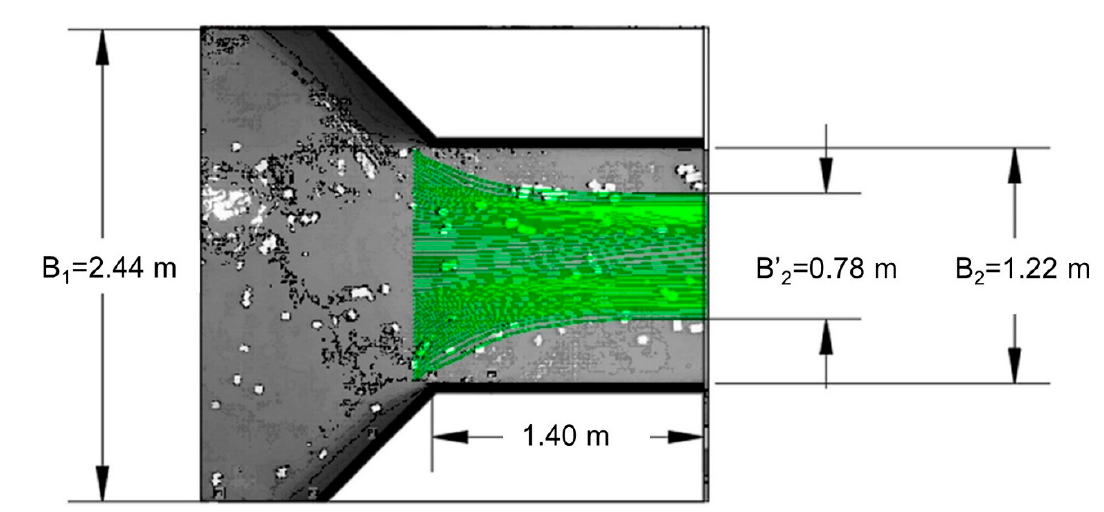
Figure 18. The measured value of vena contracta width B’ 2 obtained for experiment with B 2 /B 1 = 0.5 and discharge of 0.23 m 3 /s.